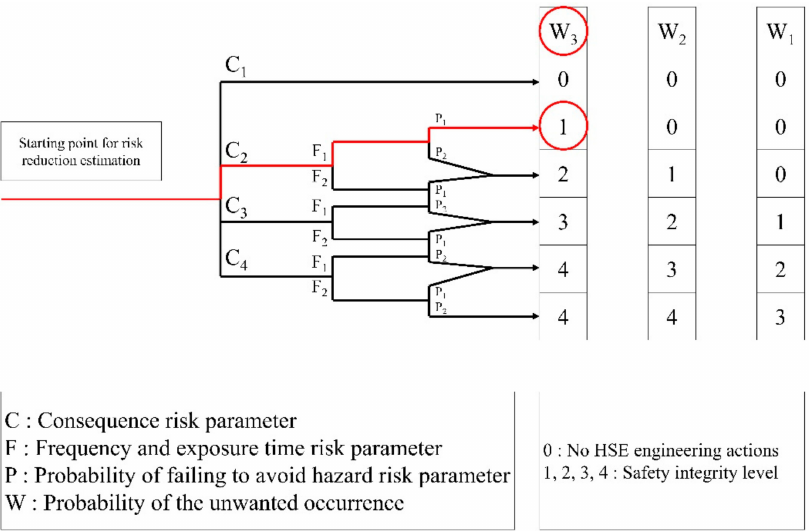
Figure 6. SSBR plant: SIL classification flowchart